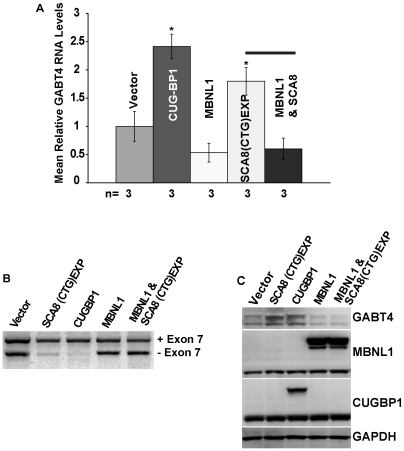
Antagonistic Regulation of GABT4 by CUGBP1 and MBNL1 in SK-N-SH cells.(A,B) qRT-PCR showing increased GABT4 transcript levels and alternative splicing changes favoring exon 7 inclusion in cells overexpressing CUGexp transcripts or CUG-BP1 but not in cells overexpressing MBNL1 1/41 or CUGexp and MBNL1 1/41. (C) Protein blot showing GABT4 is increased in cells overexpressing CUGexp transcripts or CUG-BP1, but not in cells overexpressing MBNL1/41 alone or MBNL1/41 and CUGexp transcripts.